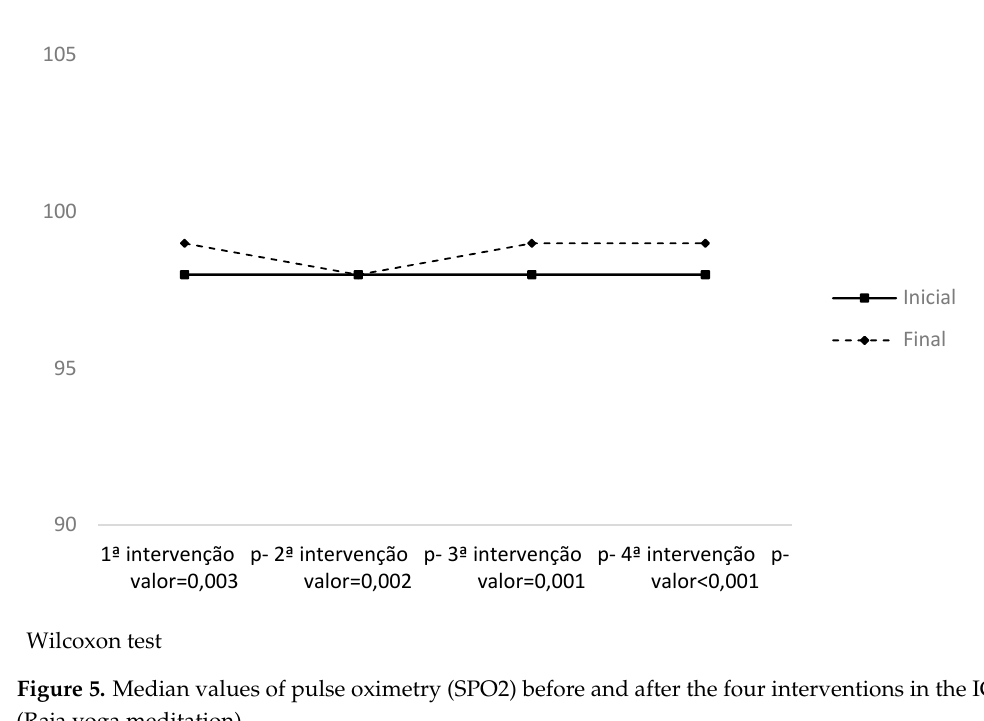
Figure 4 Median values of heart rate (HR) before and after the four interventions in the IG (Raja yoga meditation).